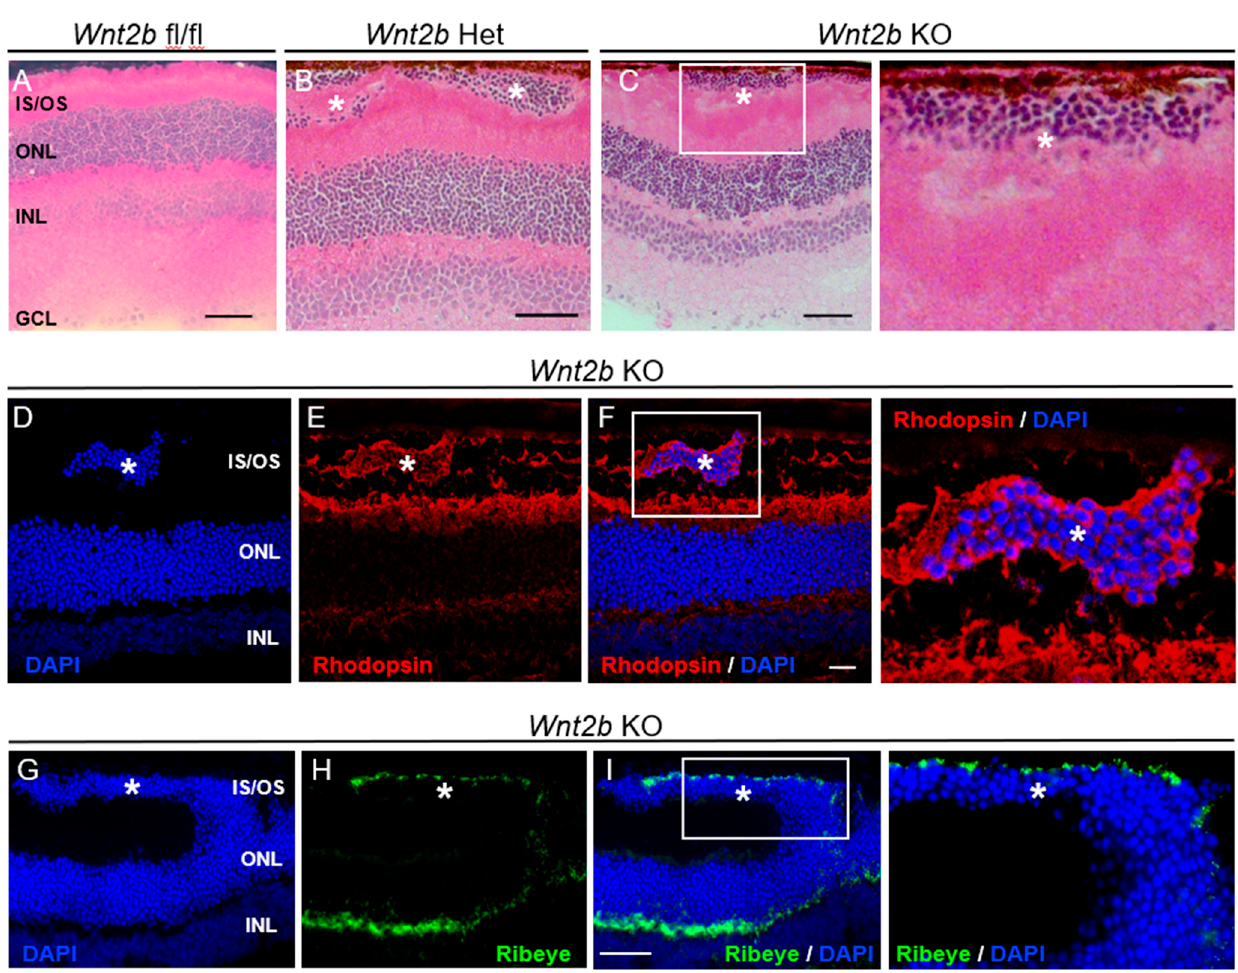
Figure 3. Ectopic rod photoreceptor nuclei found in Wnt2B Het and KO mice. ( A – C ) H&E staining on retinal cross sections from 2–3-month-old Wnt2b fl/fl ( A ), Het ( B ) and KO ( C ) mice. Ectopic nuclei can be seen in the subretinal space near RPE in Het and KO , but not fl/fl mice. * indicates ectopic nuclei in the subretinal space. Scale bars: 50 µm. An area with ectopic nuclei was enlarged on the right in the KO image ( C ). ( D – I ) Immunohistochemistry on retinal cross sections from 2-month-old Wnt2b KO eyes, stained for rhodopsin (red, E , F ), Ribeye (green, H , I ), and co-stained with DAPI (blue, D , F , G , I ). Ectopic cells (*) stained positively for rhodopsin and Ribeye, indicating their rod photoreceptor origin with ribbon synapse. Areas with ectopic nuclei were enlarged on the right in the overlay image ( F , I ). Scale bars: 20 µm ( F ), 50 µm ( I ). IS/OS: inner/outer segments; ONL: outer nuclear layer; INL: inner nuclear layer; GCL: ganglion cell layer.